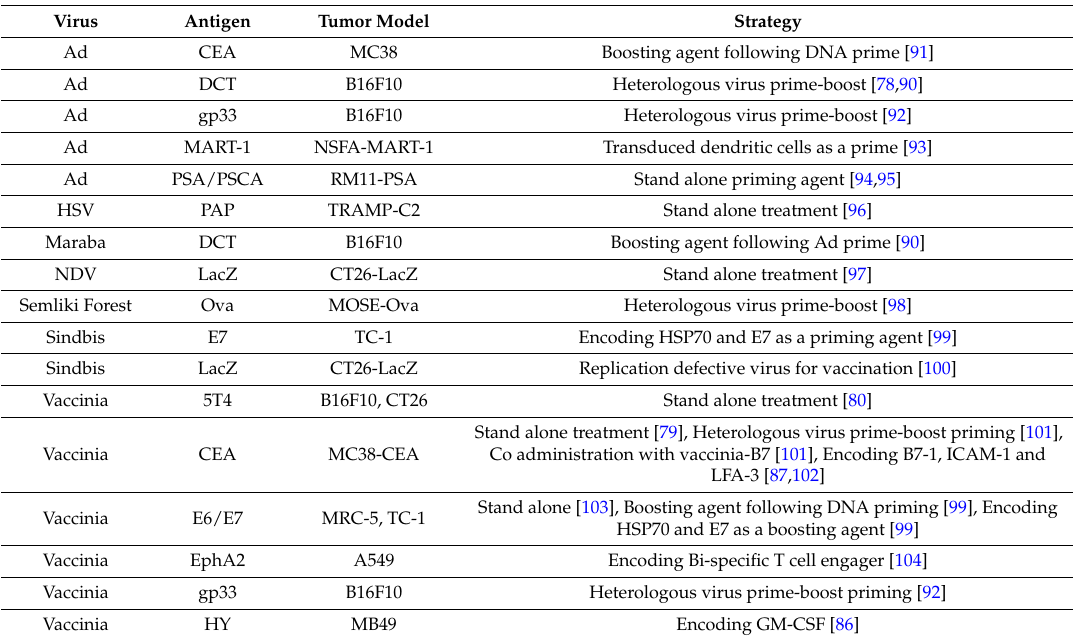
Table 1. TAA-encoding OVs used for anti-tumor